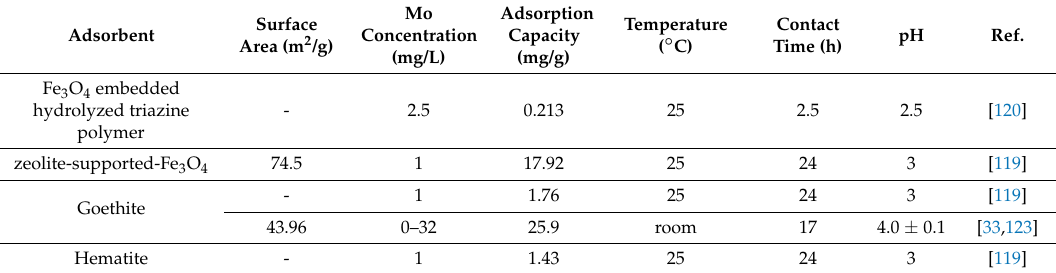
Table 6. Sorption properties of metal oxide-based adsorbents for molybdenum oxyanions removal. Adsorbent